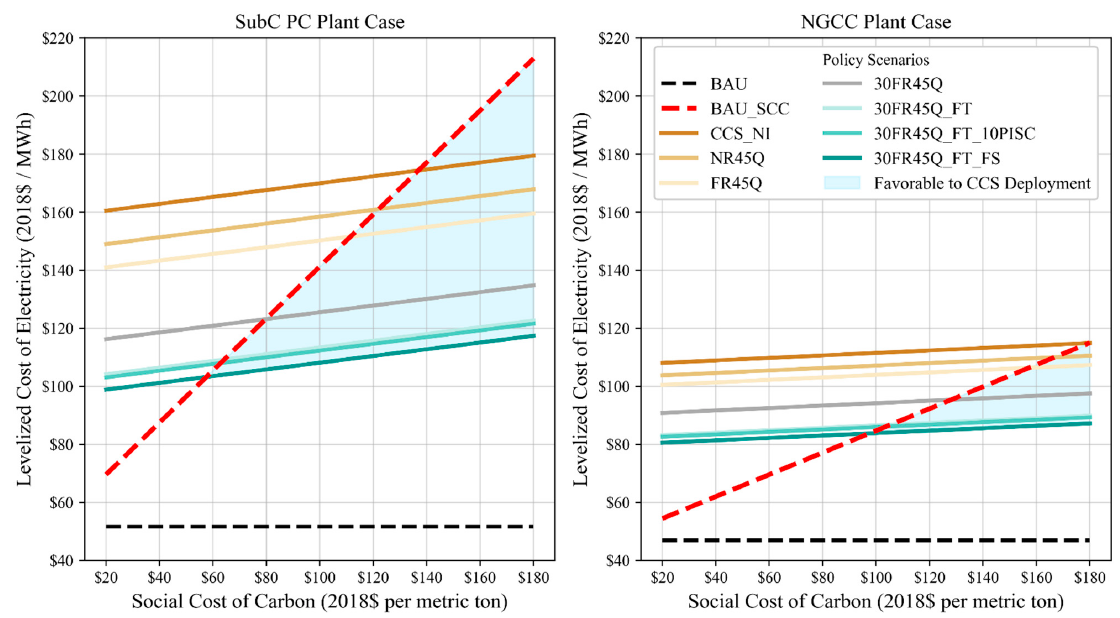
Figure 5. SCC vs. LCOE policy chart for modeled SubC PC plant ( left ) and NGCC plant ( right ). In general, the SubC PC plant is incentivized to implement CCS under much lower assumed values for the SCC as a per-unit tax on emissions relative to the NGCC plant modeled, likely because of the differences in CO 2 emissions rate per unit of electricity gen- erated (NGCC has less CO 2 emissions per MWh; therefore, its LCOE is less negatively affected by SCC increases). Analysis of the slopes of lines in Figure 5 reinforces this con- cept. For the BAU scenarios, being subject to a per-unit tax set equal to estimated values of the SCC on unabated emissions (dashed red lines; BAU_SCC), each $1.00/tCO 2 emis- sions being charged adds $0.90/MWh to the LCOE of the 650-MW SubC PC plant modeled and $0.38/MWh to the LCOE of the 727-MW NGCC plant. The SubC PC to NGCC ratio of additions to the LCOE as a result of the per-unit tax on emissions being charged ($0.90/$0.38 = 2.37) is equal to the ratio of the two plants’ pre- retrofit annual CO 2 emissions per pre-retrofit nameplate capacity (NC) as described in Equation (1). 𝑆𝑢𝑏𝐶 𝑃𝐶 𝐶𝑂 (cid:2870) 𝑃𝑒𝑟 𝑌𝑒𝑎𝑟 𝑆𝑢𝑏𝐶 𝑃𝐶 𝑁𝐶 𝑃𝑟𝑒𝐶𝐶𝑆